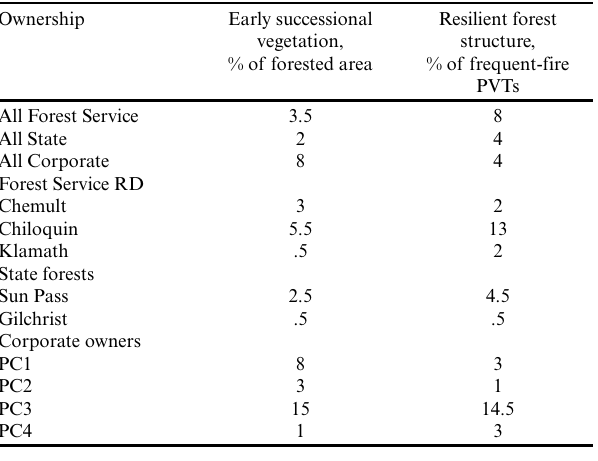
Table 7. Current ecological states by ownership